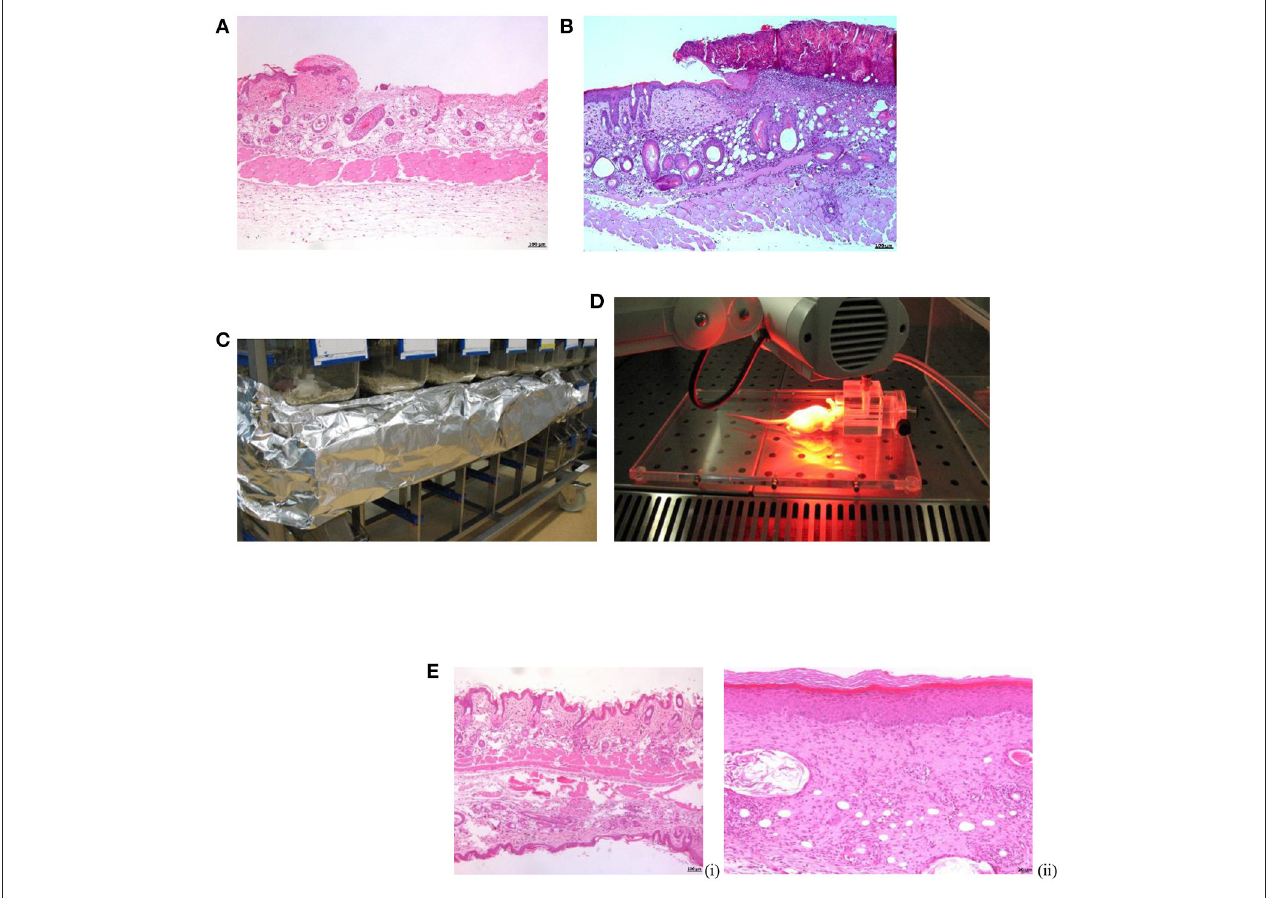
FIGURE 1 | Procedures in SKH-1 mice. (A) Microphotograph of skin abrasion experimentally induced. Note the very superficial loss of the epidermis. H-E. x50. (B) Microphotograph of the purulent crust observed at 24–48h post-infection. H-E. x50. (C) Incubation of BM (aPDT) on dark. (D) MBa-PDT session. (E)